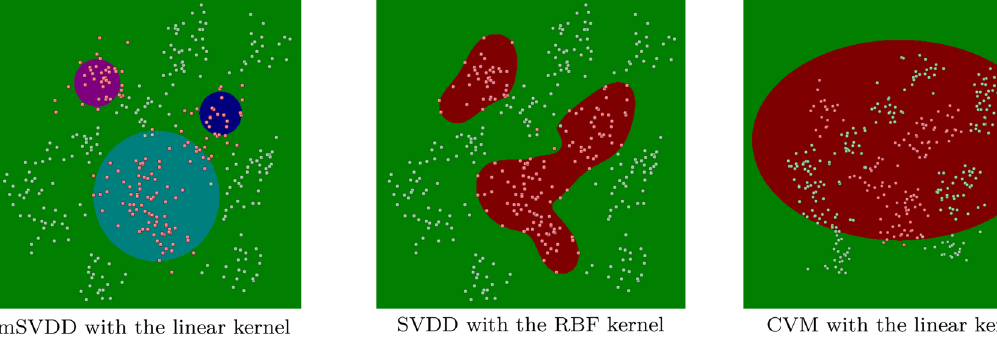
Fig. 5 Comparison of mSVDD with the linear kernel, SVDD with the RBF kernel, and CVM with the linear kernel Table 6 One-class accuracy (in Dataset %) and training time (in s) comparison